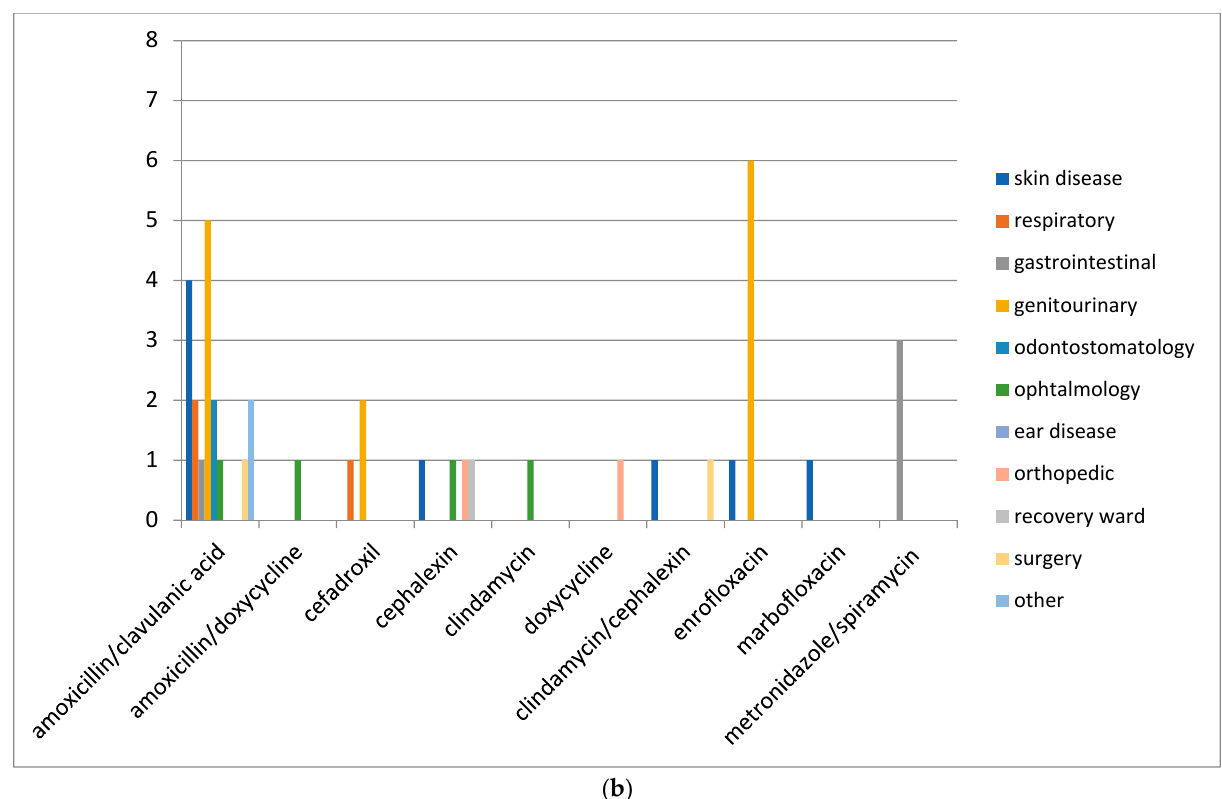
Figure 4. ( a ) Distribution of No. 387 antimicrobial treatments according to the organ/system (conditions) in dogs after the mandatory use of VEP. ( b ) Distribution of No. 41 antimicrobials treatments according to the organ/system (conditions) in cats after the mandatory use of VEP (from April 2019 to March 2020).